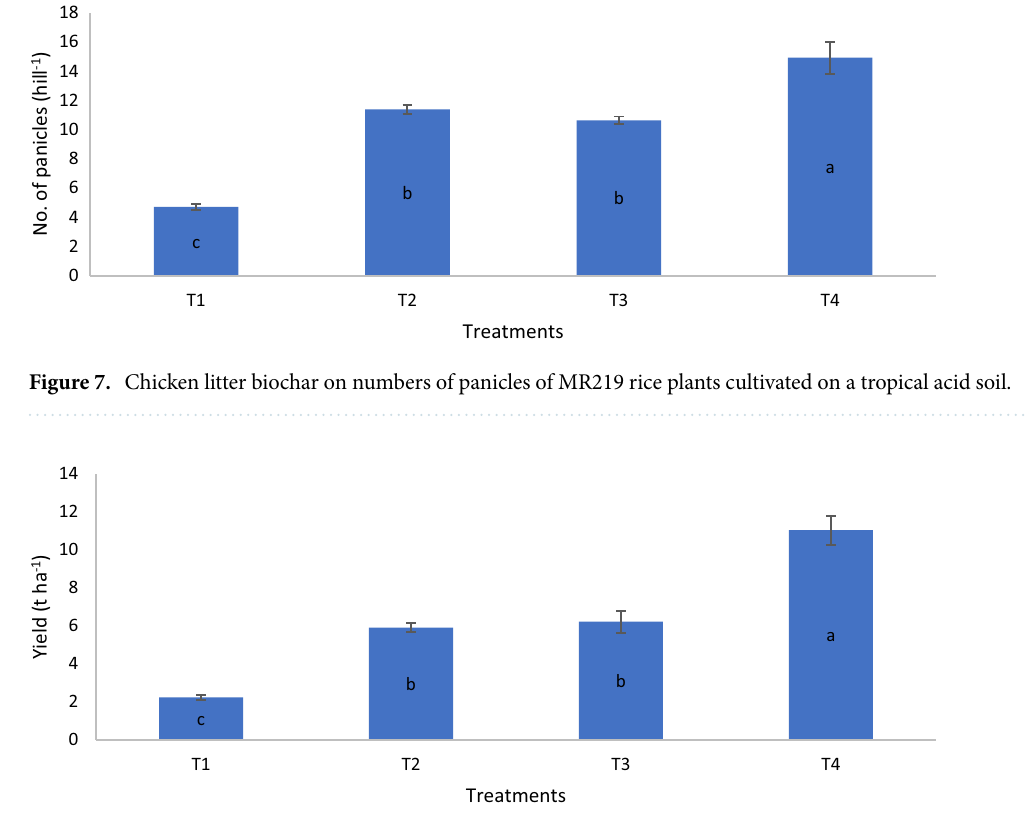
Figure 8. Chicken litter biochar on rice grain yield of MR219 rice